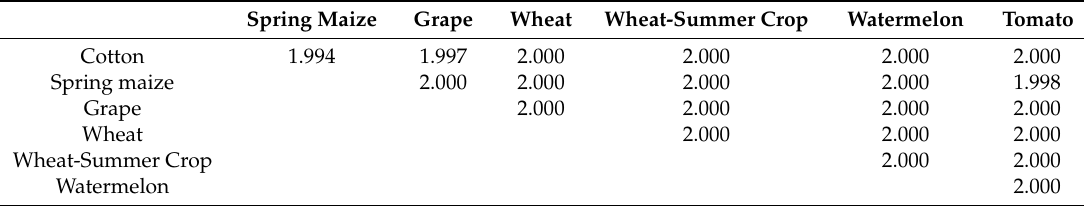
Table 7. JM distances for all pair-wise crop comparisons during the entire time